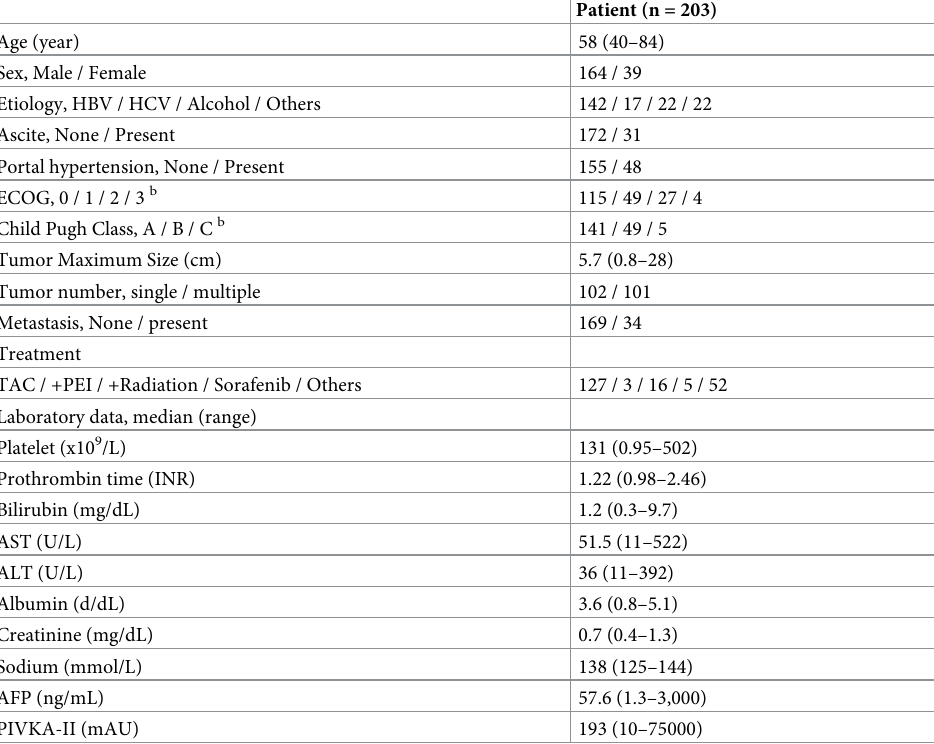
Table 1. Baseline patient characteristics a